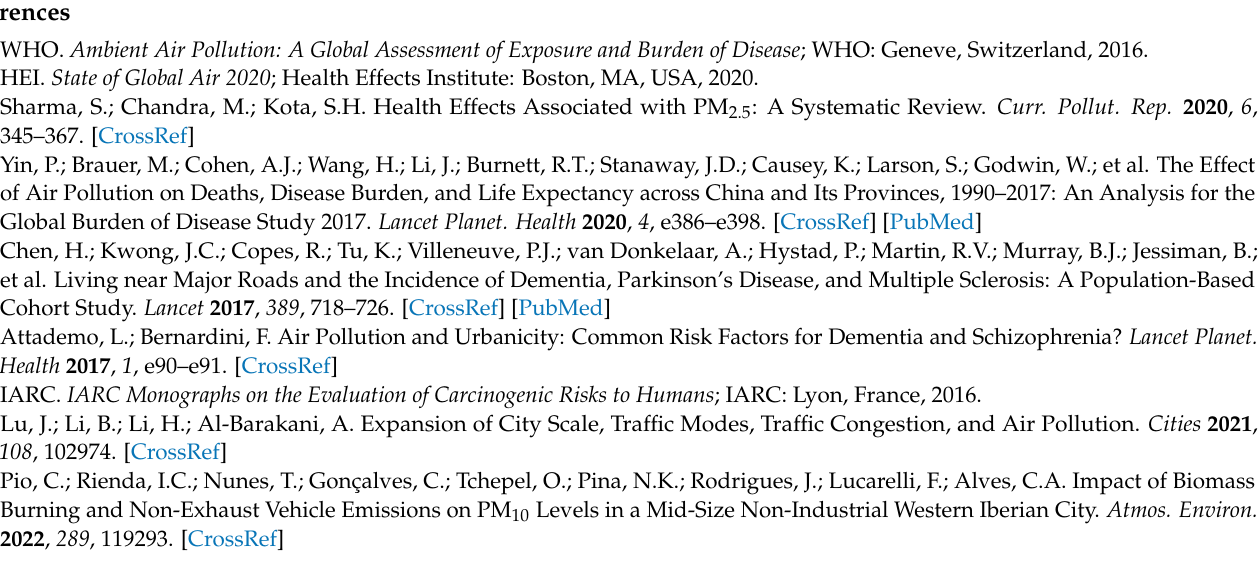
of sampling sites. Source: Google Earth image. Figure S2: Multi-storey indoor parking. Figure S3: The shopping mall (FORUM Aveiro) and the entrance for loading trucks, vans, and other vehicles. Table S1: Dust loadings and emission factors. Table S2: Element oxide mass concentration for major and minor elements in the sampling sites. Table S3: The geoaccumulation index (I geo ) and the values obtained in the three parking areas. Table S4: PAHs content. Table S5: Results for the bioluminescence bioassay with Aliivibrio fisheri bacteria, including EC 50 (% and mass concentration) and toxic units